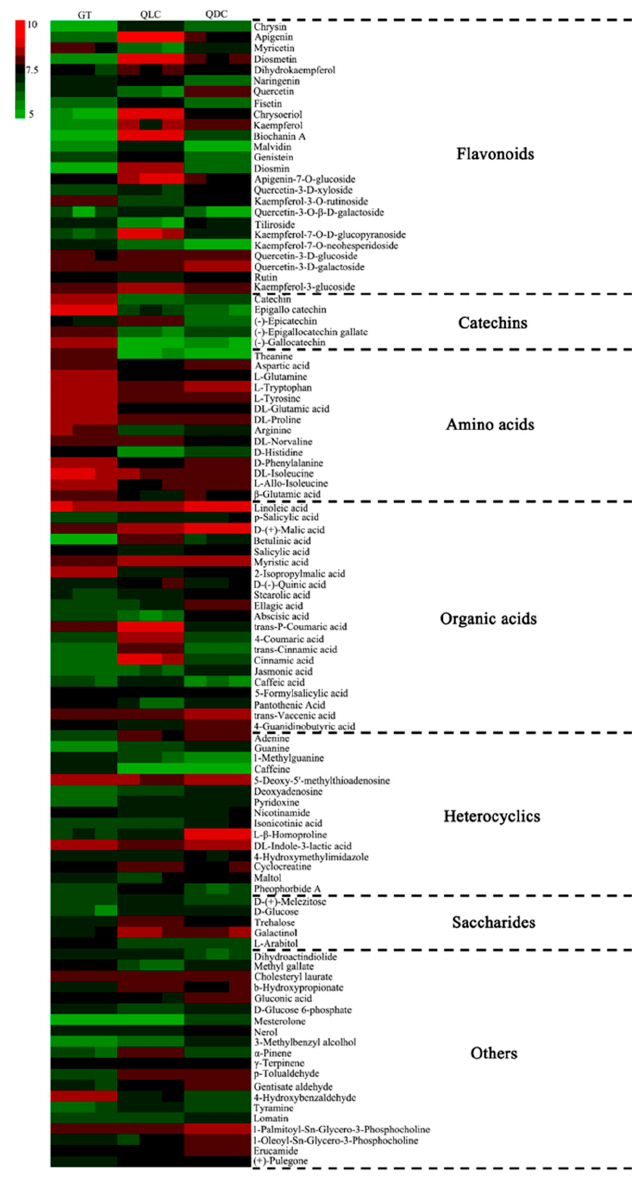
Figure 3. A heat map of the relative amounts of the differentially accumulated metabolites (DAMs) in the three tea samples. The scale (ranging from 5.0 to 10.0) represents the log10 (Abundance) of the DAMs. Color-coding is graded from green to red with the relative intensity shift from low to high, respectively. 3.2.4. Organic Acids, Heterocyclics, Saccharides, and Other Components Sour and sweetness are not the main taste characteristics of C. sinensis green tea, but they can supplement and adjust the overall taste of C. sinensis green tea [25,34]. In general,